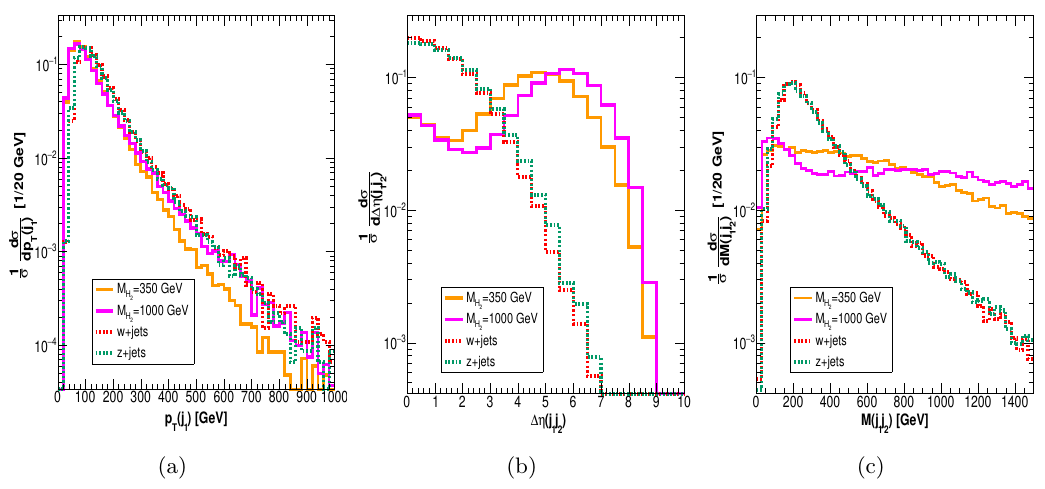
Figure 16 . Normalised Distribution of transverse momentum of the leading jet (figure 16(a)), dif- ference in pseudo-rapidity (figure 16(b)) and invariant mass of the leading and sub-leading jets (fig- ure 16(c)), for both signal and background events. The distributions are without any selection